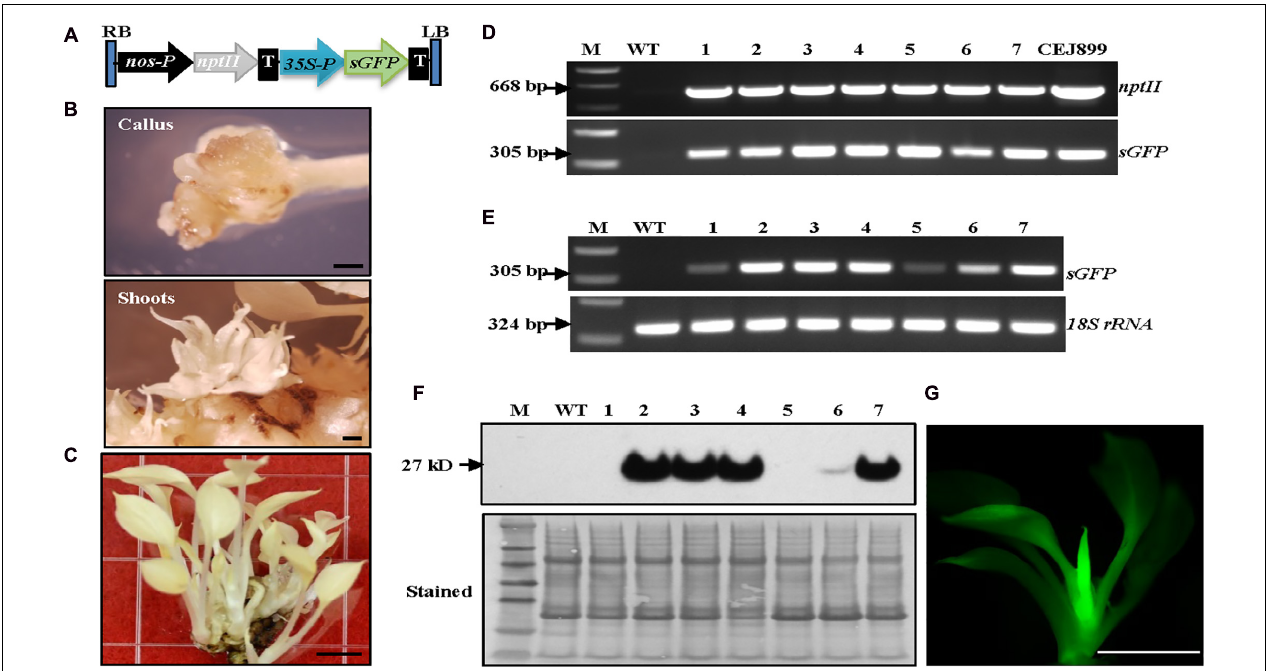
FIGURE 2 | Establishment of Agrobacterium -mediated transformation system in albino plants expressing sGFP. (A) Genetic cassette CEJ899 with sGFP driven by CaMV35S promoter (35S-P) and nptII driven by nos promoter (nos-P). T, nos terminator; RB, right border; LB, left border. (B) Induced calli and shoots. Bar = 1 mm. (C) Regenerated transgenic plantlets. Bar = 5 mm. (D) Genomic DNA PCR and (E) RT-PCR of seven individual transgenic lines (1–7) amplified by specific primer pairs for nptII and sGFP , respectively, using 18S rRNA as an internal control. M, molecular marker; WT, wild-type albino plant. (F) Immunoblot against anti-GFP. Stained blot shows equal protein loading. (G) GFP fluorescence of a transgenic plantlet. Bar = 5 mm. TABLE 1 | The induction rates of kanamycin-resistant calli and subsequently regenerated shoots. Transgene